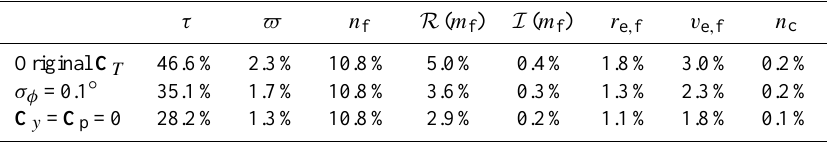
Table 7. Percent error for the segment 170 retrieval with HSRL data. The first row represents the original uncertainty assessment. The second is the uncertainty if the error covariance matrix is altered to represent a pitch angle uncertainty reduction from 0.5 ◦ to 0.1 ◦ . The last row represents the uncertainty if there is no contribution to the error covariance matrix from heading or pitch error.